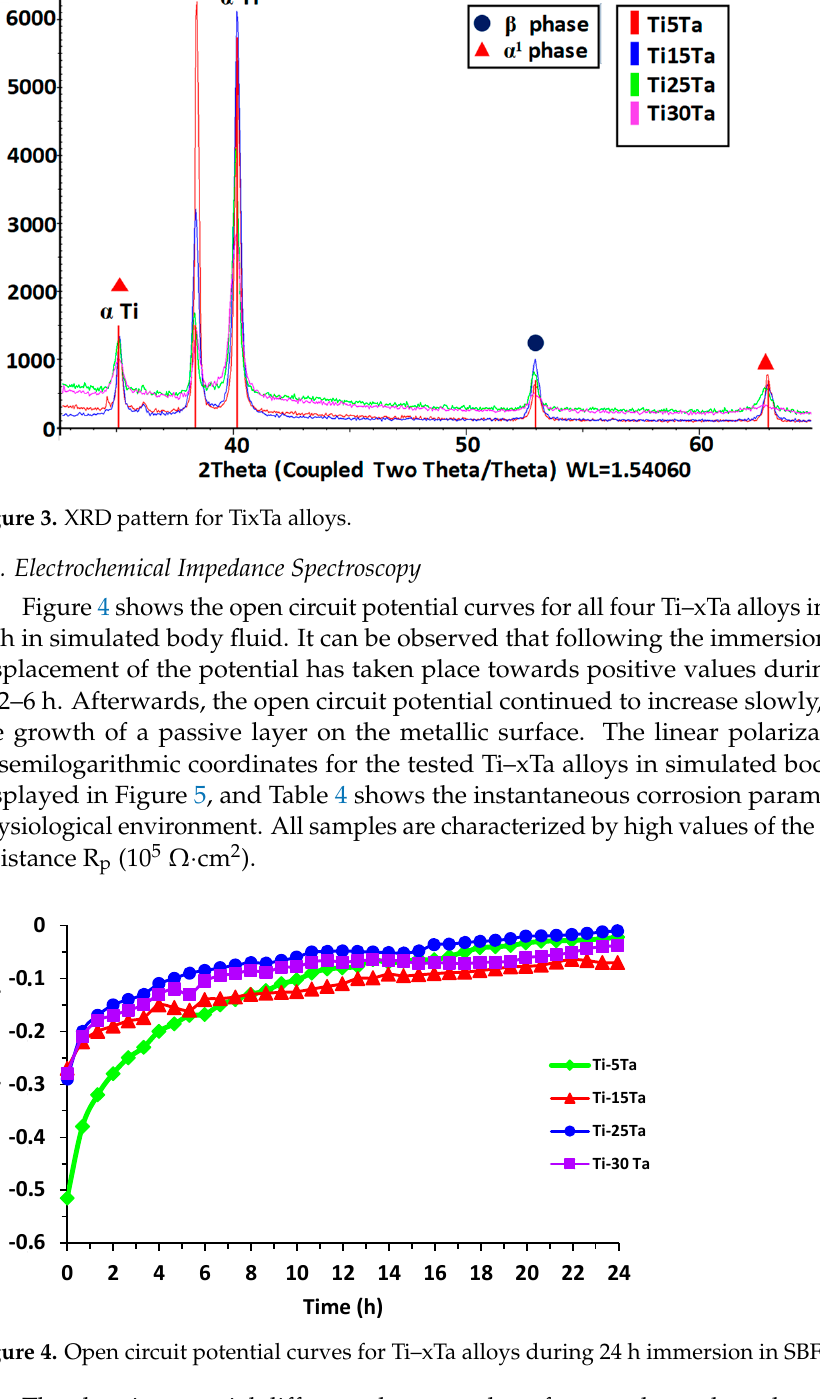
Figure 3. XRD pattern for TixTa alloys.